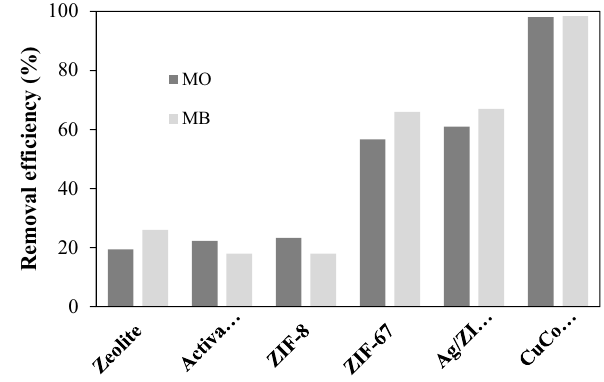
Figure 10: Comparison of MO and MB removal e ffi ciency among other heterogeneous catalysts and CuCo - ZIFs. MO: pH 7.0, catalyst dosage = 100 mg · L − 1 , [ H 2 O 2 ] = 0.2 mol · L − 1 , initial [ MO ] = 35 mg · L − 1 , time = 60 min, and ambient temperature. MB: pH 3.0, catalyst dosage = 50 mg · L − 1 , [ H 2 O 2 ] = 0.1 mol · L − 1 , initial [ MB ] = 40 mg · L − 1 , time = 100 min, and ambient